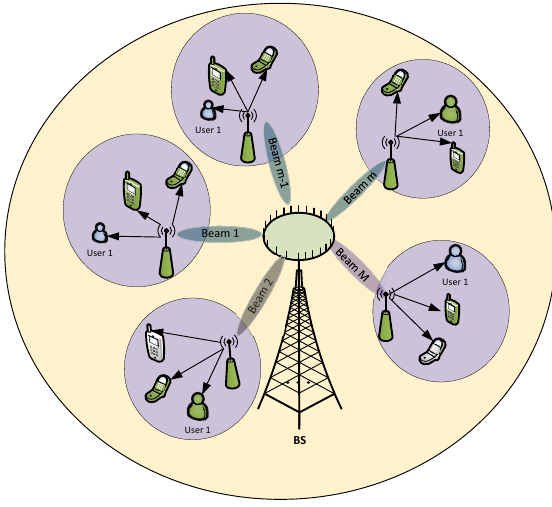
Figure 1. The proposed system model.